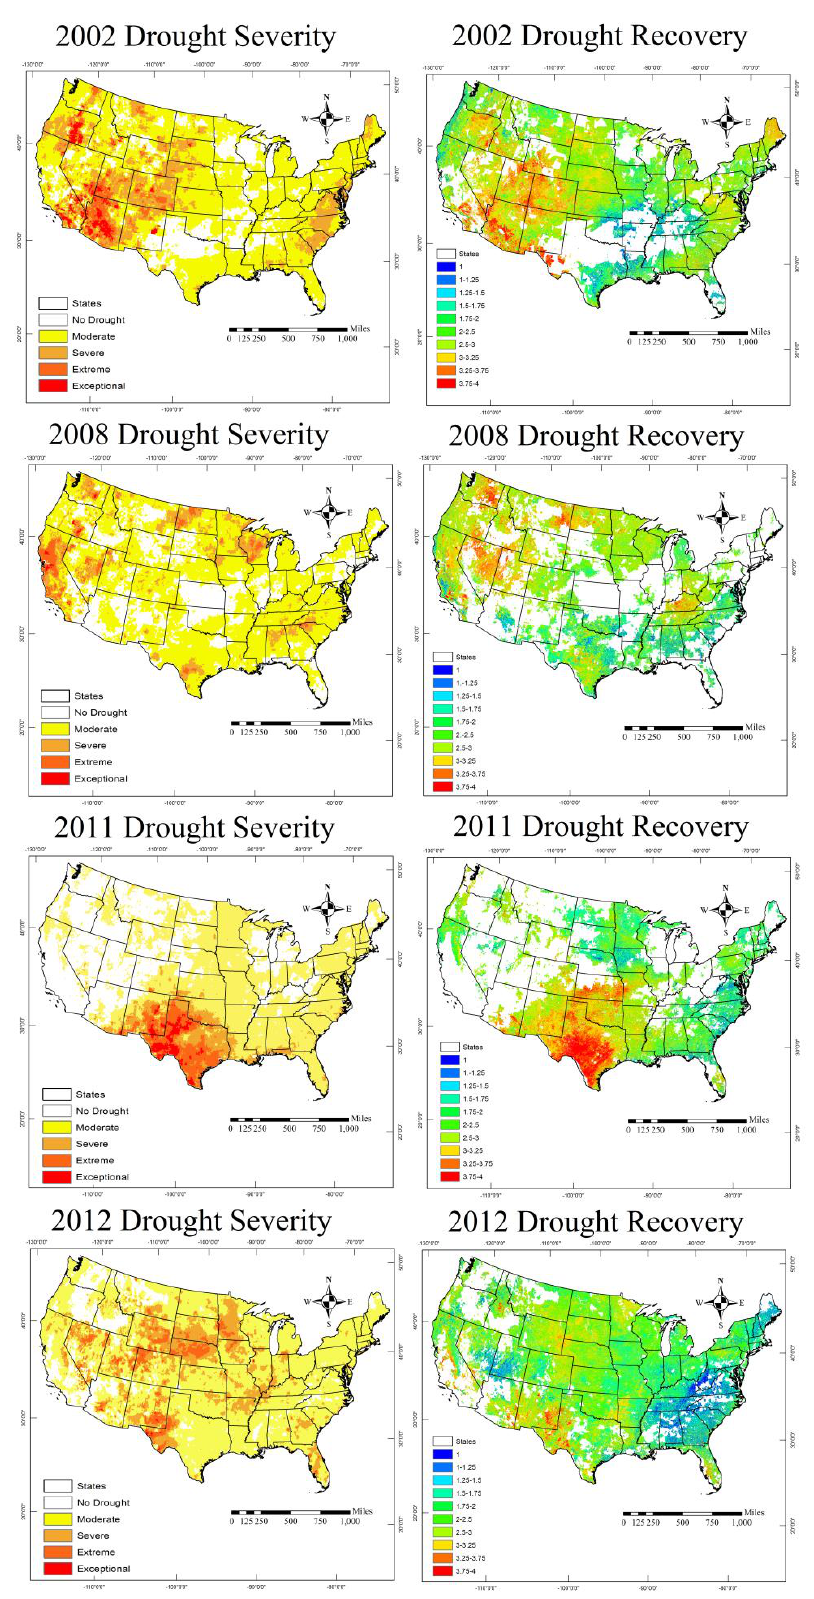
Figure 4. Spatial distribution of drought severity (left) and drought recovery duration (right) for 2002, 2008, 2011 and 2012 drought